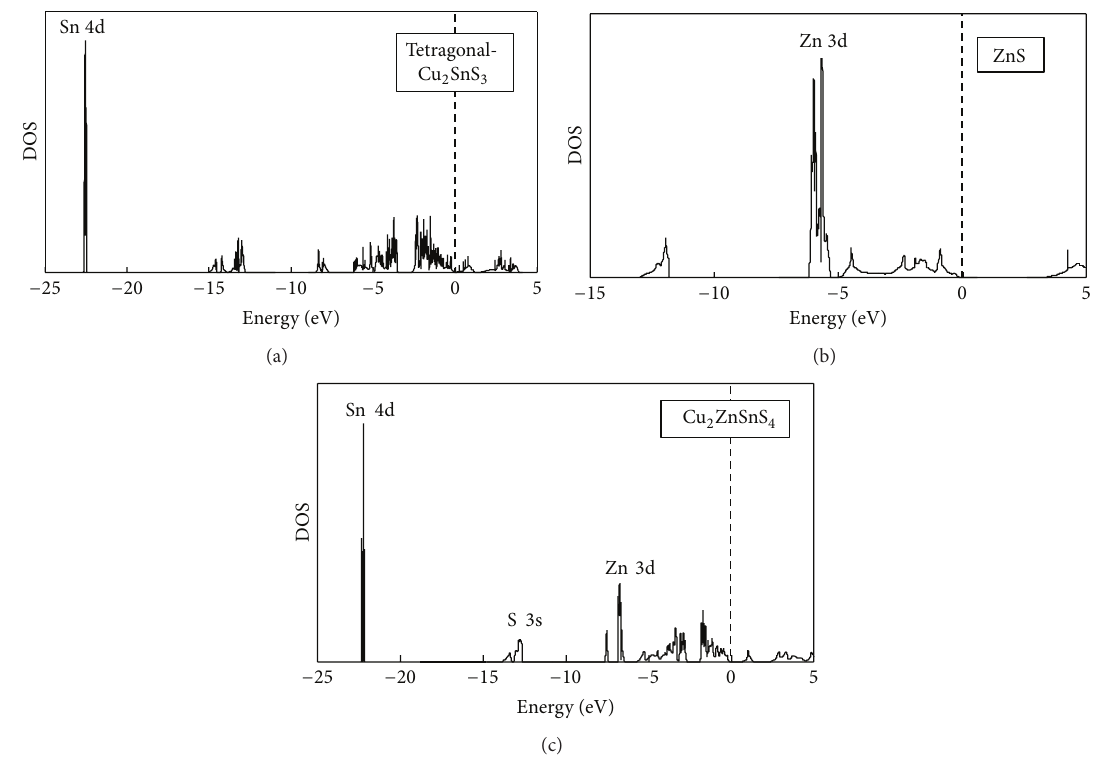
Figure 4: Density of states (a) for tetragonal structure of CTS, (b) for ZnS, and (c) for kesterite